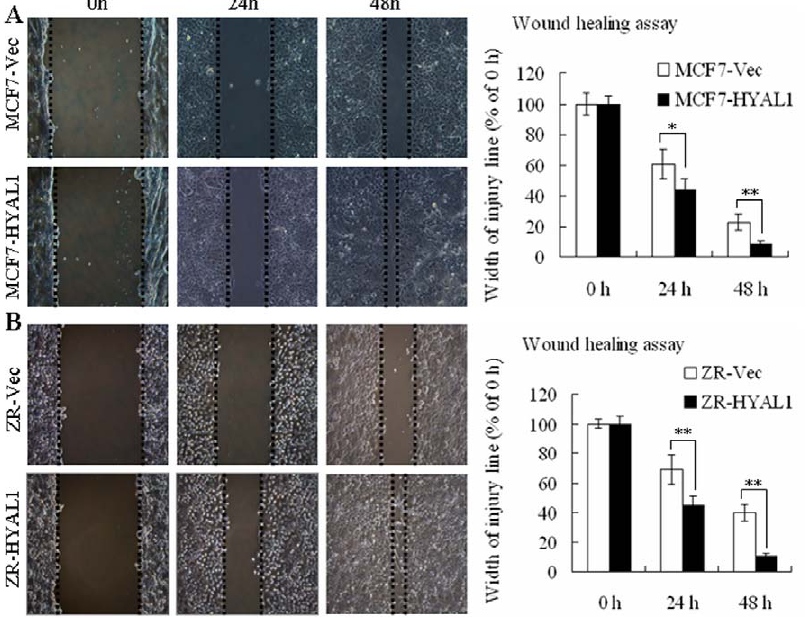
Figure 5. Upregulation of HYAL1 in breast cancer cells promoted cells migration in vitro. The MCF7-HYAL1 (A) and ZR-HYAL1 (B) transfectants promoted wound closure compared with their respective empty vector transfected cells ( p , 0.05, p , 0.01, respectively), (original magnification 6 100).